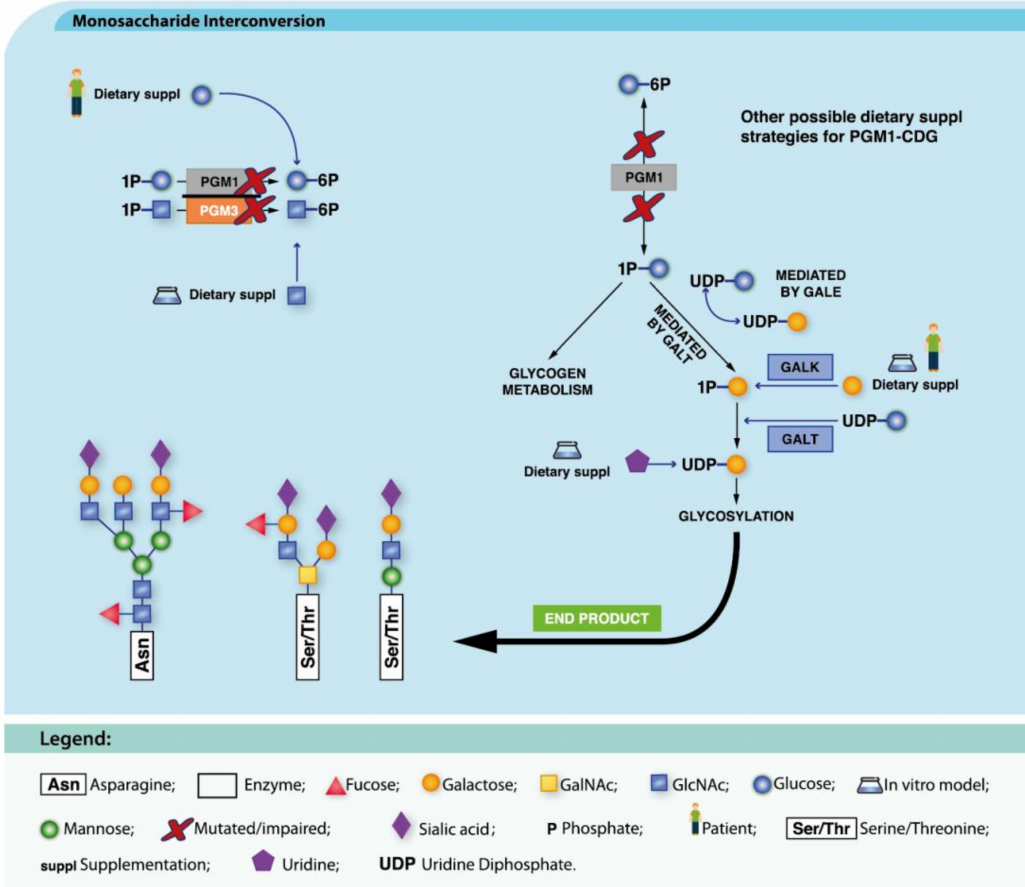
Figure 3. Dietary supplementation approaches under investigation for PGM1-CDG and PGM3-CDG. GlcNAc supplementation has been tried in vitro for PGM3-CDG (blue arrow) while for PGM1-CDG, Glc, uridine and Gal (blue arrows) have been tried. These therapeutic approaches aim to recover the metabolic pathways (black arrows) and ultimately, the normal glycosylation profile (bold black